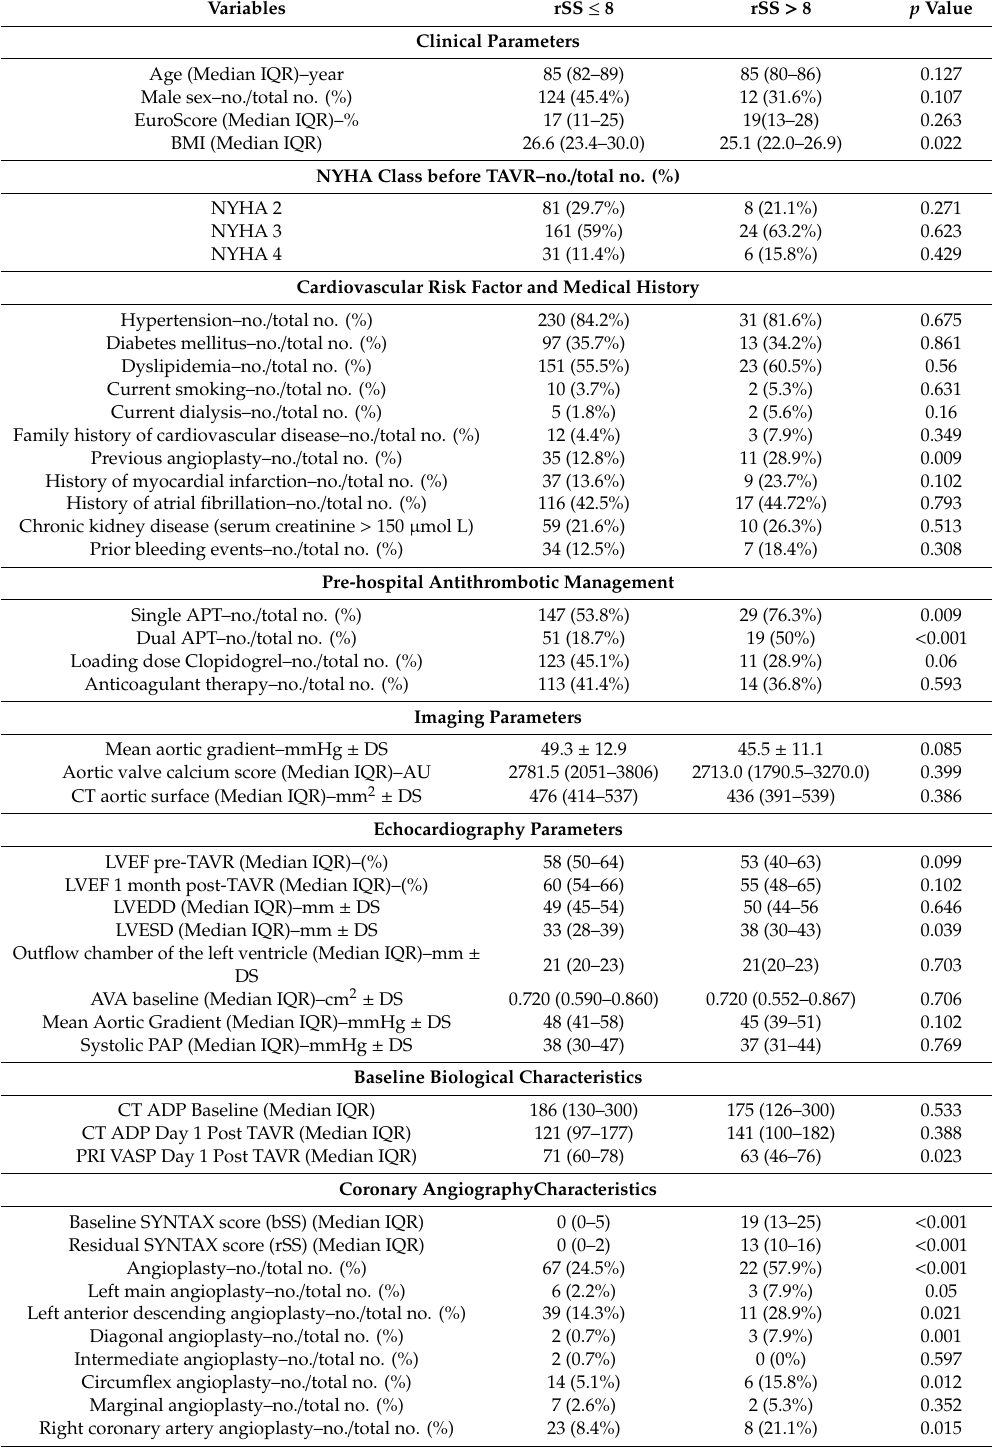
Table 1. Baseline characteristics according to residual SYNTAX score